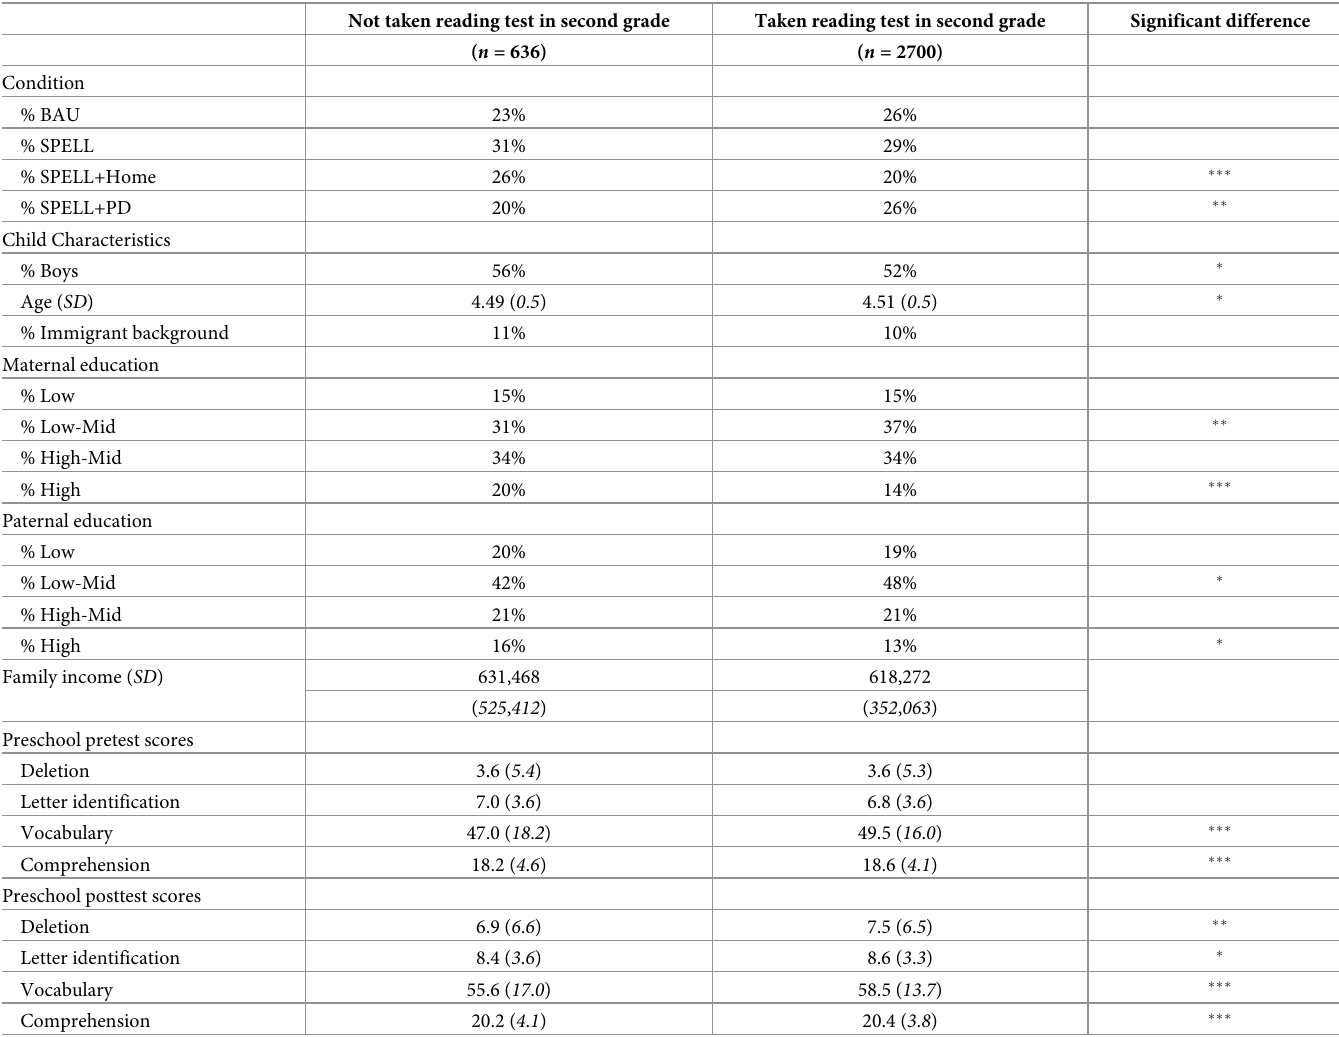
Table 1. Comparison of the complete sample of children in the original SPELL who did take and who did not take the reading test in second grade. Not taken reading test in second grade Taken reading test in second